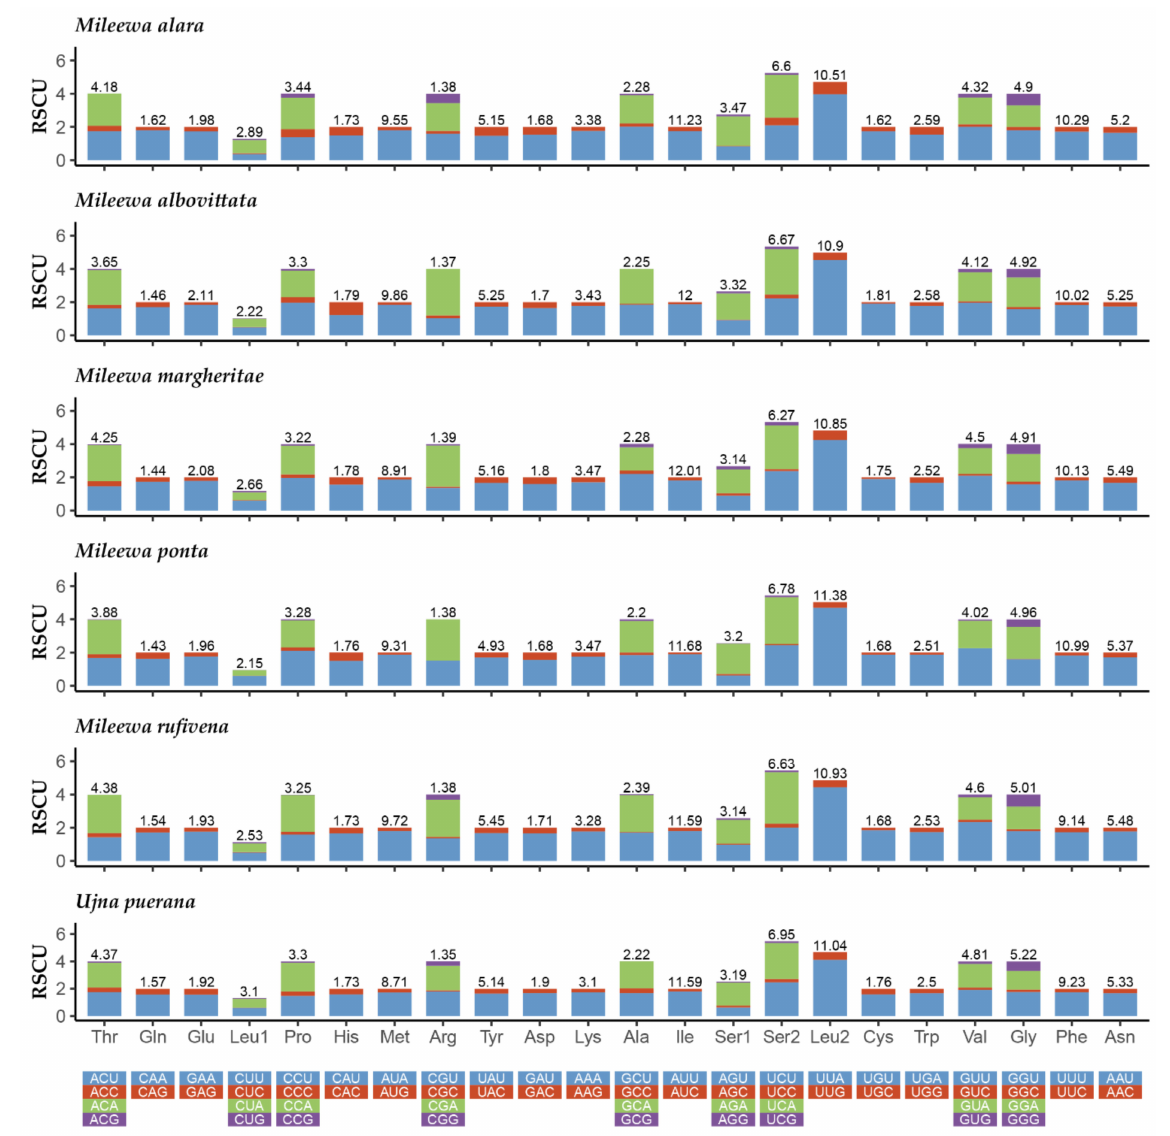
Figure 3. Relative synonymous codon usage (RSCU) in the mitogenomes of six Mileewinae